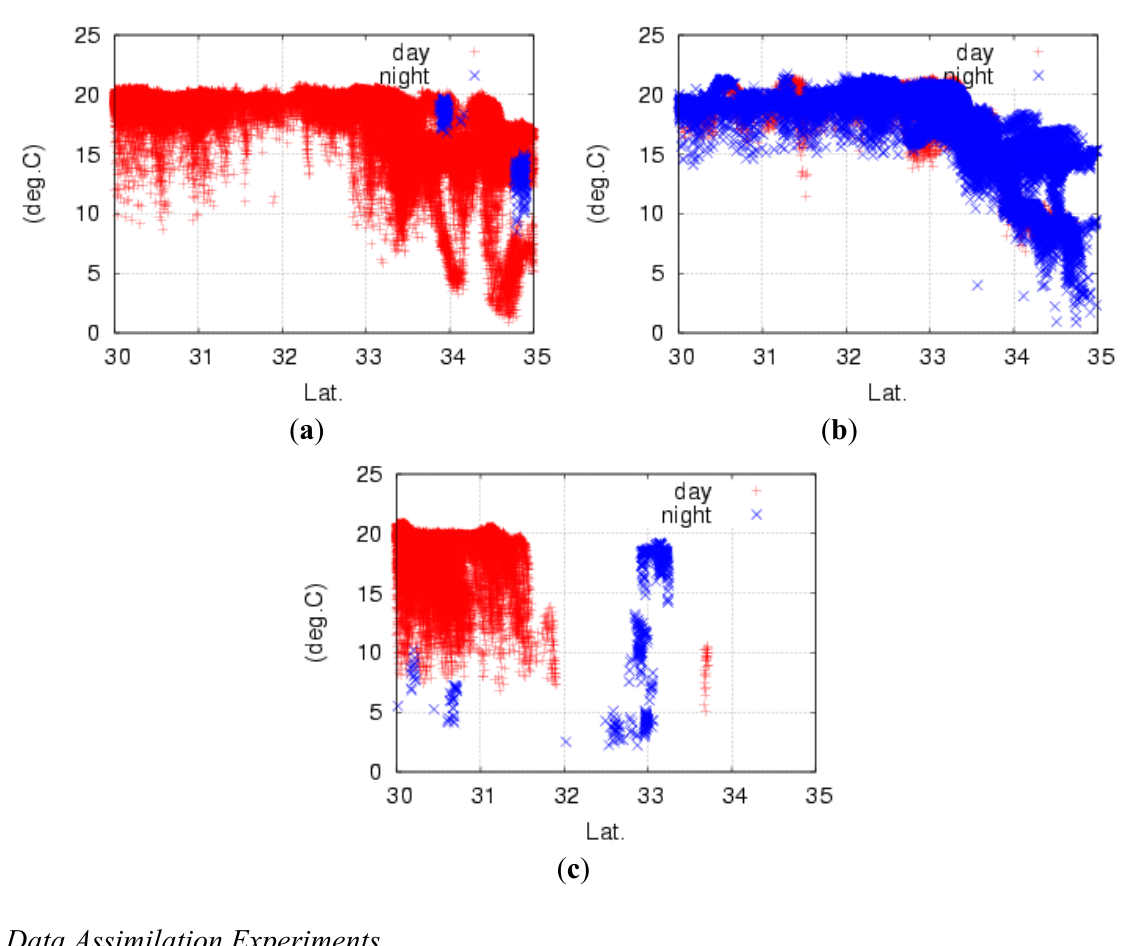
Figure 2. Scatter plots of sea surface temperature at each latitude used for the analyses on 14 February 2010 ( a ), 20 February 2010 ( b ), and 26 February 2010 ( c ). Crosses: daytime, X signs: night